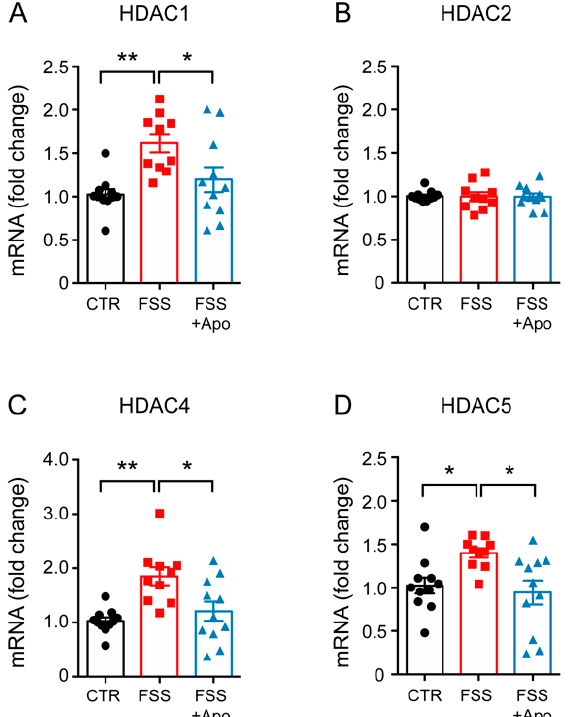
Figure 4. Apocynin prevents the FSS ‐ induced increase of Hdacs expression. ( A – D ) mRNA levels of Hdac1 ( A ), Hdac2 ( B ), Hdac4 ( C ), and Hdac5 ( D ) measured in the hippocampus (HPC). One ‐ way ANOVA followed by Tukey’s post hoc analysis. Data are presented as mean SEM ( n = 10–11 mice/group). * p < 0.05; ** p < 0.01.